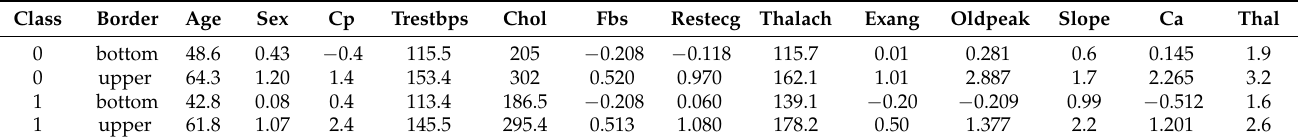
Table 10. Range of